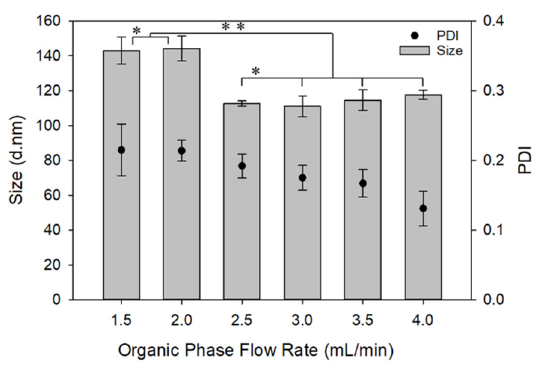
Figure 5. Effect of the flowrate ratio on NP size and PDI. For this study, the concentration and flowrate of the PVA solution (aqueous stream) was 10 mg/mL and 25 mL/min, respectively. The concentration of PLGA solution was 5 mg/mL, and its flowrate varied from 1.5 to 4 mL/min. * No statistically significant difference in the size of the NPs prepared with 1.5 or 2.0 mL/min organic phase flow rate, or between the NPs prepared with 2.5 to 4.0 mL/min organic phase flow rate ( p > 0.05). ** Statistically significant difference between the size of NPs prepared with 1.5–2.0 mL/min and those prepared with 2.5–4.0 mL/min organic phase flow rate ( p < 0.05).